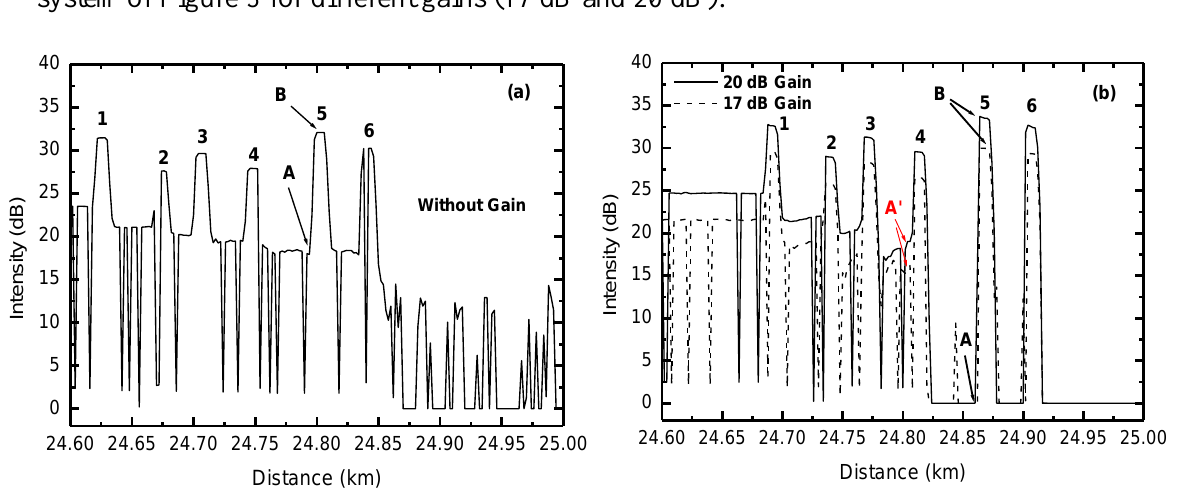
Figure 4. OTDR traces for the non-amplified ( a ) and amplified ( b ) multipoint sensor system of Figure 3 for different gains (17 dB and 20